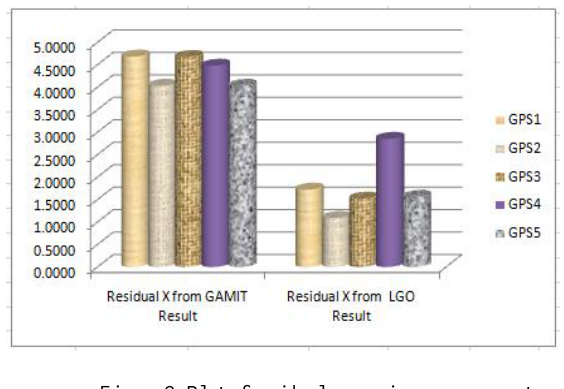
Figure 2. Plot of residual errors in x-component as computed from LGO and GAMIT (unit is in m scaled by 100)